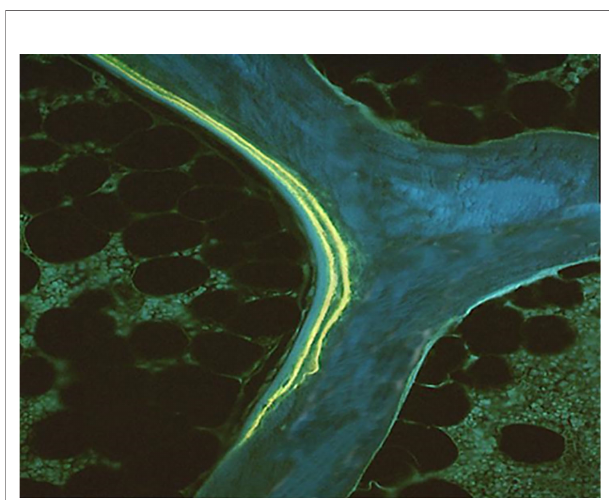
FIGURE 1 | Double tetracycline labels. Unstained section under ultraviolet light;